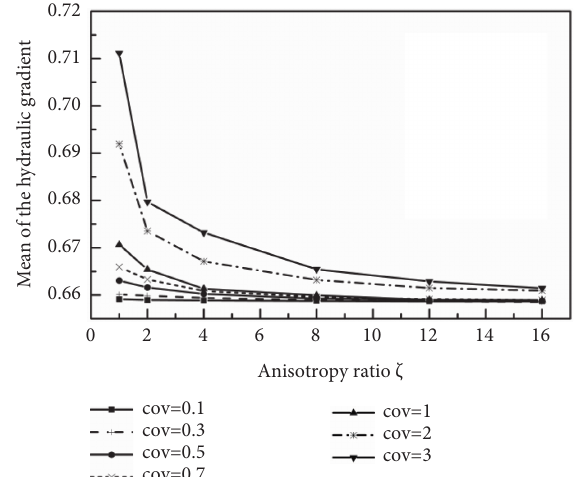
Figure 9: Variation of the mean of hydraulic gradient with the hydraulic conductivity for different values of ζ .